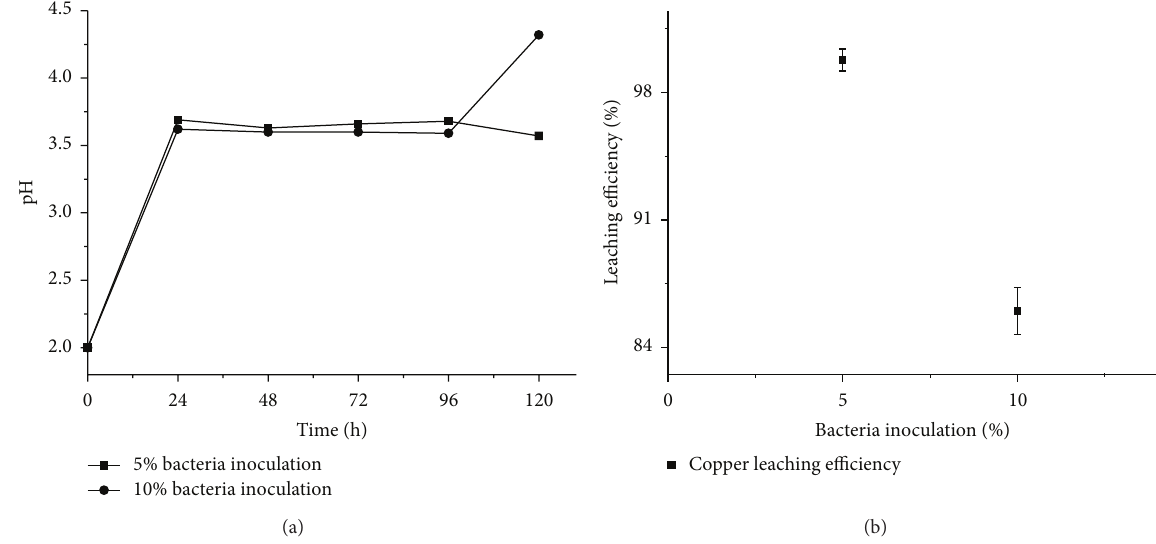
Figure 5: Different bacteria inoculation and medium pH changed with time (a) and 5 days leaching and copper leaching efficiency (b).